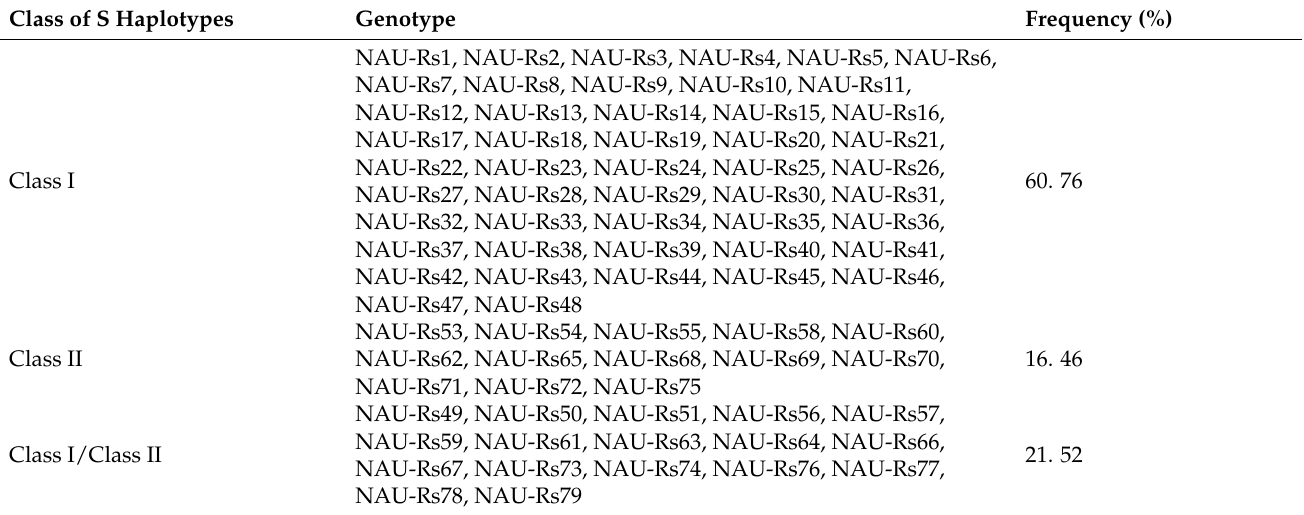
Figure 1. PCR amplification of SRK kinase domain in radish. ( A ) PCR amplification results of KD(I)-F/R in NAU-R1-NAU-R79; ( B ) PCR amplification results of KD4/KD7 in NAU-R49-NAU-R79. Table 2. The classification of S haplotypes in radish.